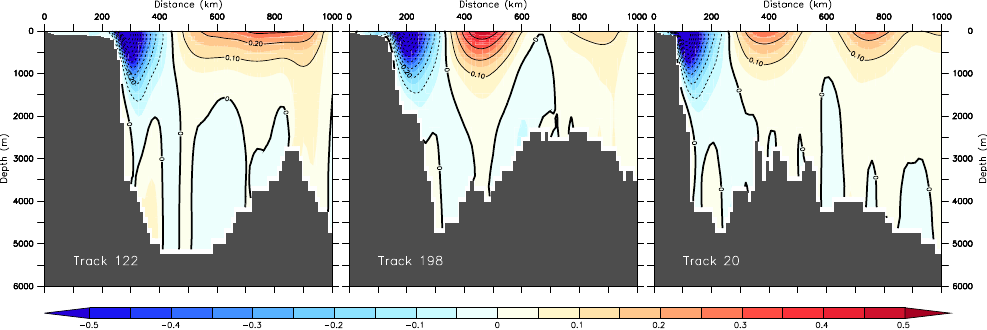
Figure 6. Depth profiles of the 60-year averaged velocity component normal to the satellite tracks in the INALT01. Positive values are in the northeast direction.